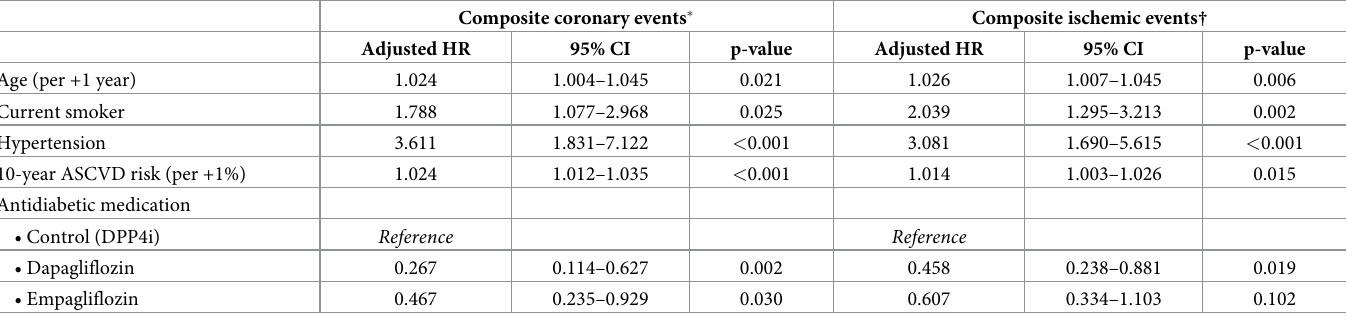
Table 3. Multivariable predictors of ischemic